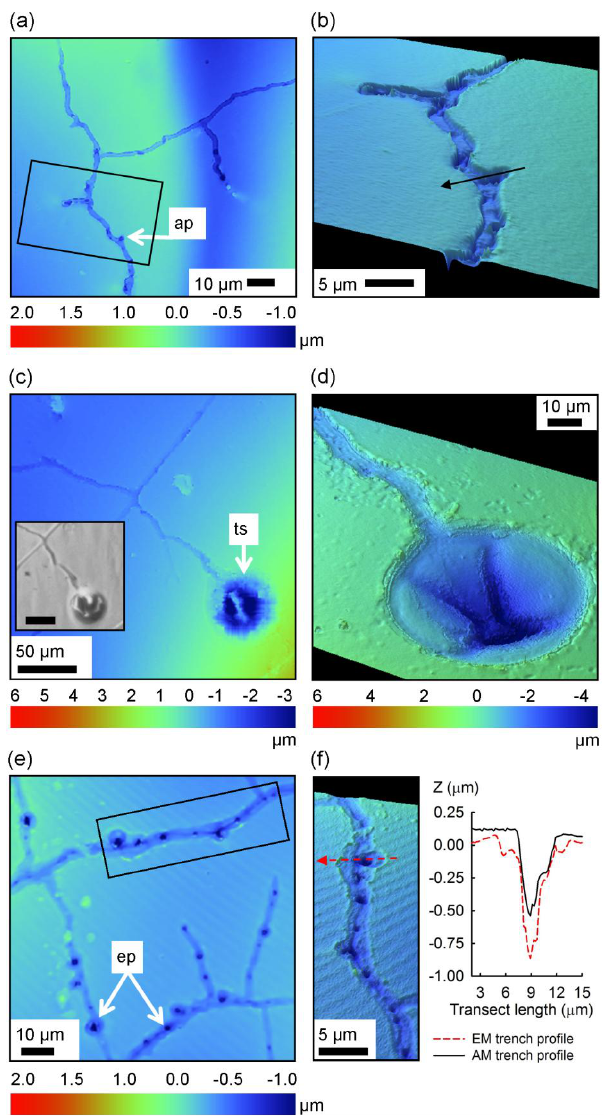
Fig. 2. Alteration of silicate mineral surfaces by symbiotic fungal hyphae. (a) Linear trench features on muscovite in an AM Sequoia treatment at 500 ppm [CO 2 ] a exhibiting the angular hyphal projections (ap) diagnostic of Glomeromycotean (AM-forming) fungi. The area within the rectangular box in (a) is magnified and projected in 3D in (b) to emphasise the morphology of the fungal trenches. The profile of the solid/black transect arrow is plotted in (f). (c) Physical disruption of muscovite beneath AM Sequoia at 1500 ppm [CO 2 ] a associated with a terminal spore (ts), as confirmed by light microscopy (inset; scale bar is 50 µm). (d) Surface disruption, asso- ciated with a terminal spore produced in muscovite beneath an AM Acer sapling at 1500ppm [CO 2 ] a . (e) Surface alteration by trench- ing and pitting of muscovite beneath EM Betula saplings; the area within the rectangular box is magnified in (f) to reveal morpholog- ical details of etch pits (ep) and the dashed red transect arrow is plotted. All units are